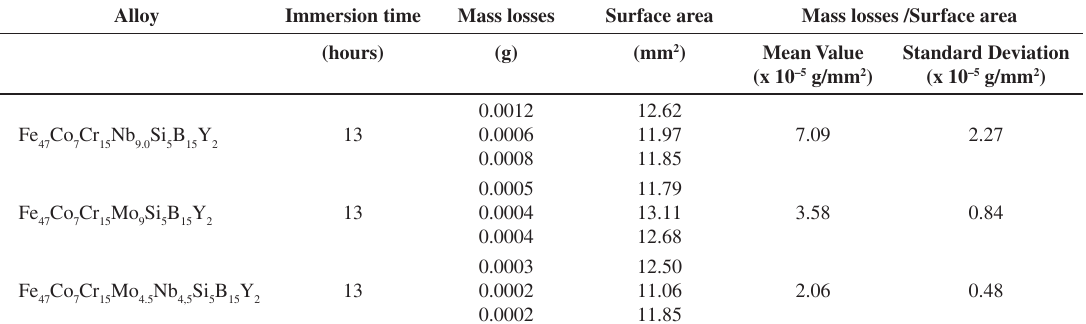
Table 4. Mass losses resulting of as cast alloys immersed in 4M HCl.